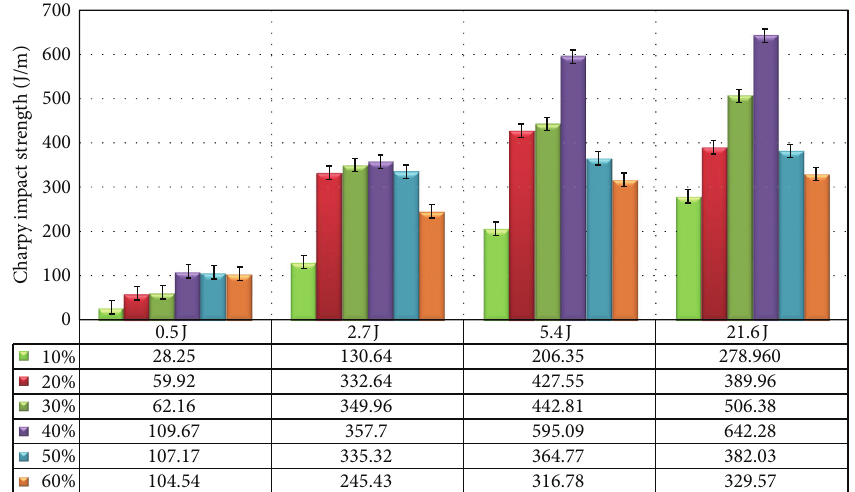
Figure 8: Effect of fiber content on impact strength of kenaf/PVB composites at different energy levels.